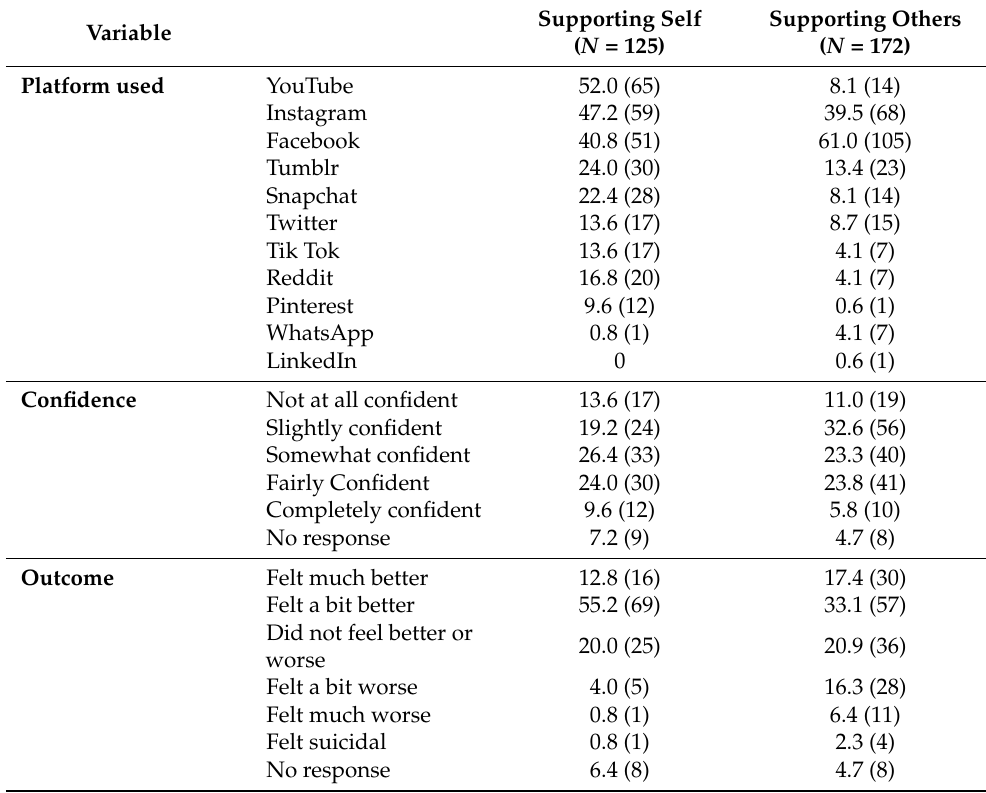
Table 6. Platform used, confidence and influence on mood % ( n